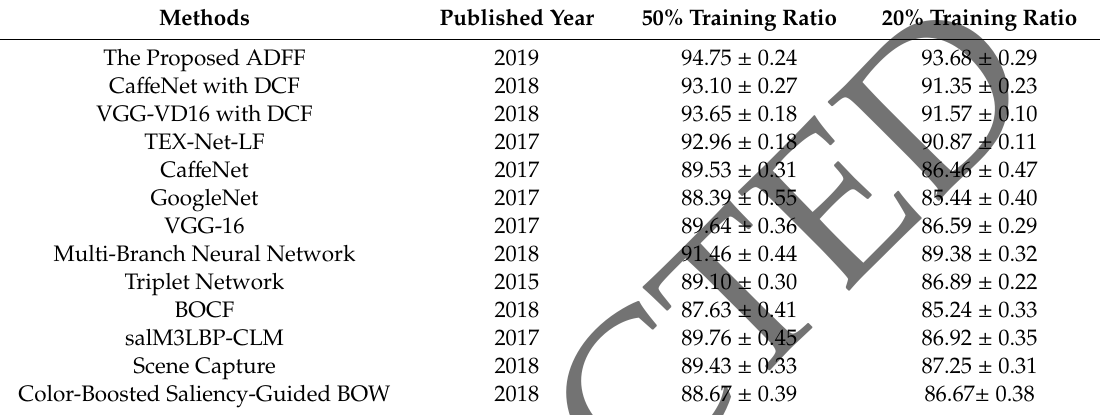
Table 3. Standard deviations and overall accuracy (%) of the ADFF framework and all baseline algorithms with 20% and 50% training ratio in the AID